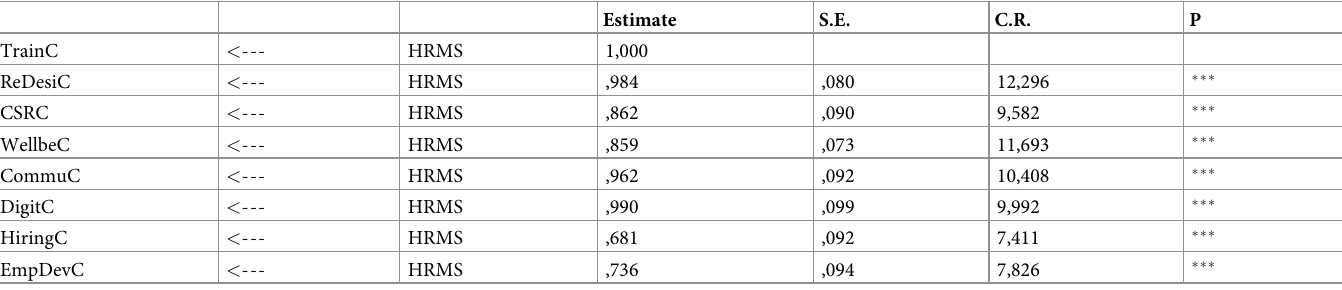
Table 4. Latent variable